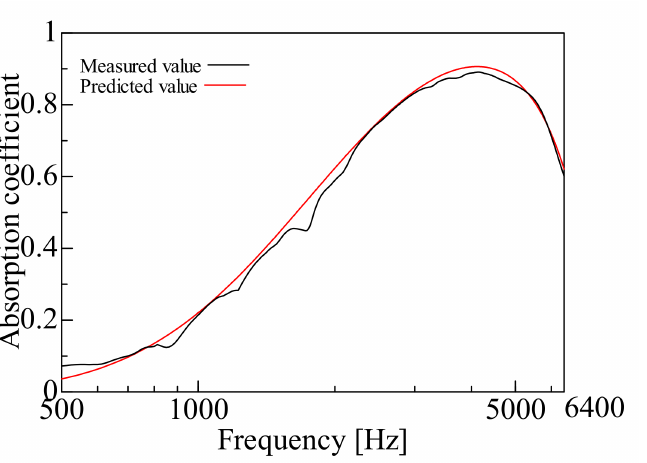
Figure 12. Comparison between the experiment and prediction (Sample D, m = 0.12 g/m 2 , t = 230 µ m, ρ = 348 kg/m 3 ).